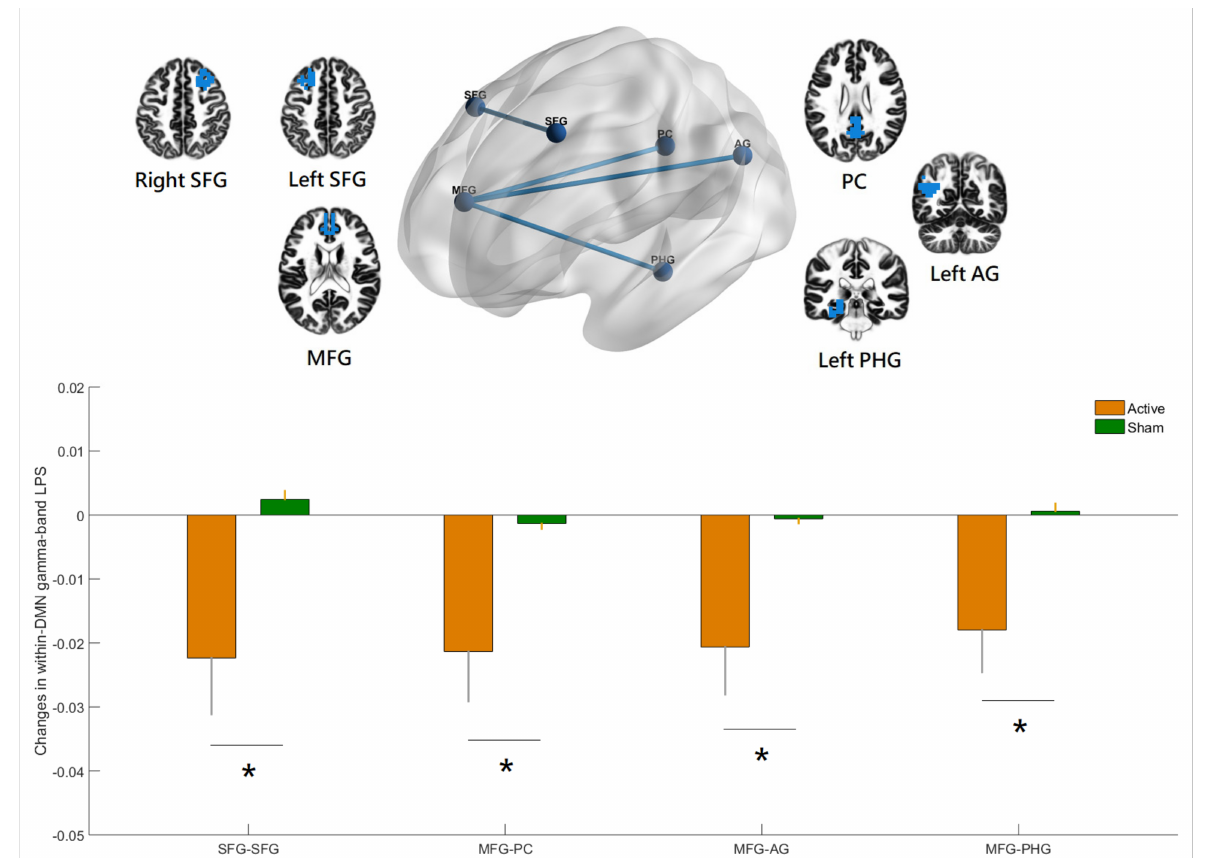
Figure 3. Relative to the sham, the hf-tRNS group had significant decreases in gamma-band within- network lagged phase synchronization (LPS) in the default mode network (DMN) from baseline to the end of stimulation (all p values < 0.05, corrected), specifically between the medial frontal gyrus (MFG) and the left angular gyrus (AG), between the MFG and the left parahippocampal gyrus (PHG), between the MFG and the posterior cingulate (PC), and between the right and the left superior frontal gyrus (SFG). The figure was created using eLORETA and BrainNet Viewer. Regions of interest (ROIs) shown here are displayed on a 5 × 5 × 5 MNI template brain in eLORETA for analyses (5 mm resolution is used). Error bars indicated standard errors. * p < 0.05